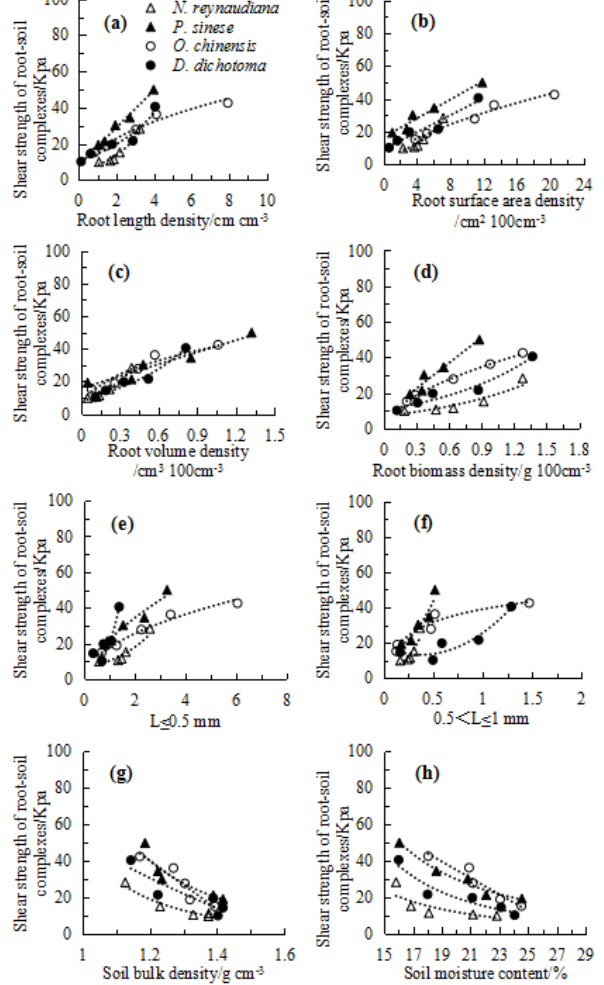
Figure 9. Relationship between the shear strength of the root–soil complexes and root length density ( a ), root surface area density ( b ), root volume density ( c ), root biomass density ( d ), root diameter ( L ) of less than or equal to 0.5 mm ( e ), root diameter ( L ) between 0.5 and 1 mm ( f ), soil bulk density ( g ), and soil moisture content ( h ).